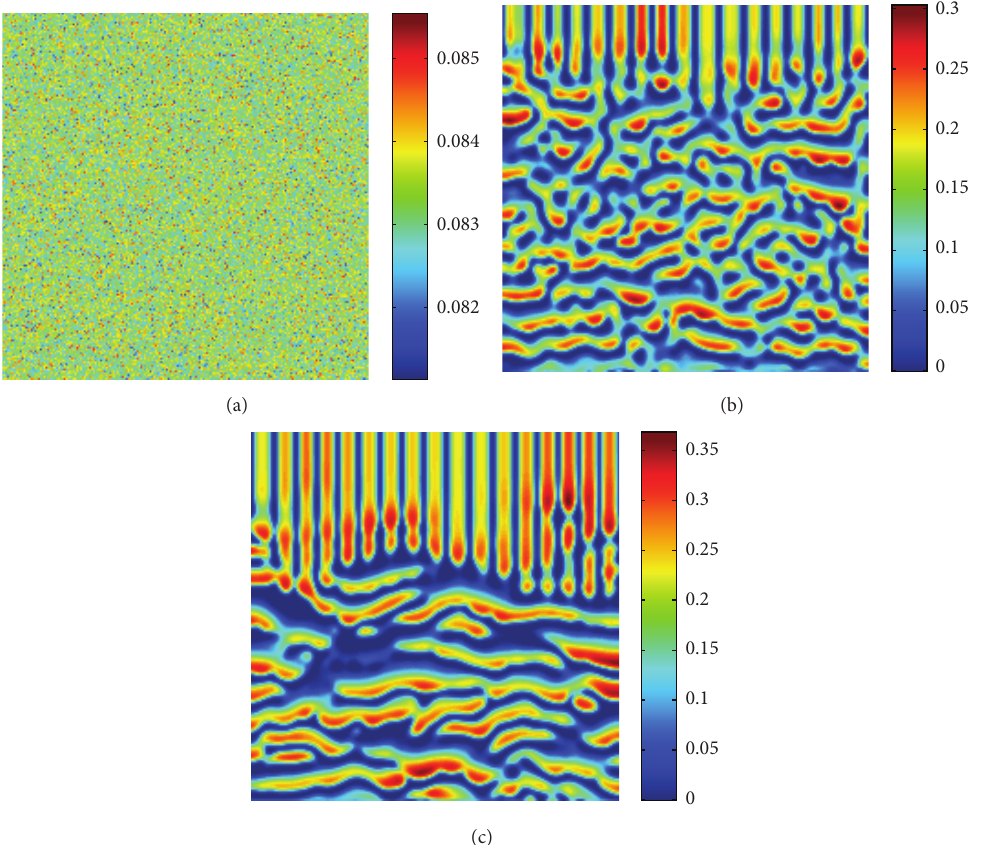
Figure 7: Snapshots of contour diagrams of the time evolution of algae at different points in time with 𝑁 = 0.25, 𝐷 2 = 0.5, V = 0.1 . (a) 0 iterations, (b) 50000 iterations, and (c) 100000